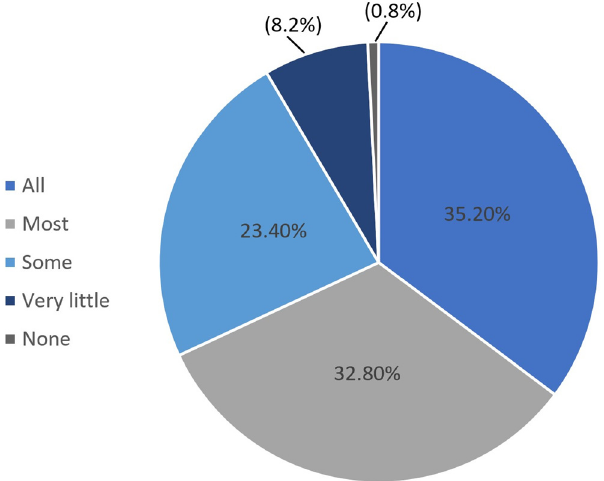
Figure 3. Amount of extra food purchased among participants who reported stockpiling.